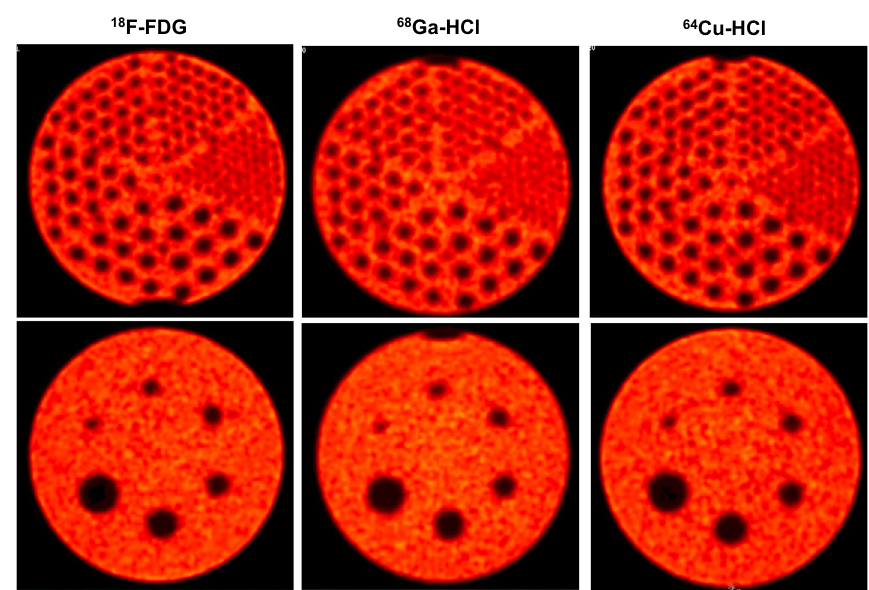
Fig. 2 PET images of the Jaszczak phantom filled with 18 F-FDG (left), 68 Ga-HCl (middle), or 64 Cu-HCl (right). Transversal planes at the height of the rods (top) and spheres (bottom). Images were acquired and reconstructed using the same scanner and reconstruction methods and used for qualitative evaluation of spatial